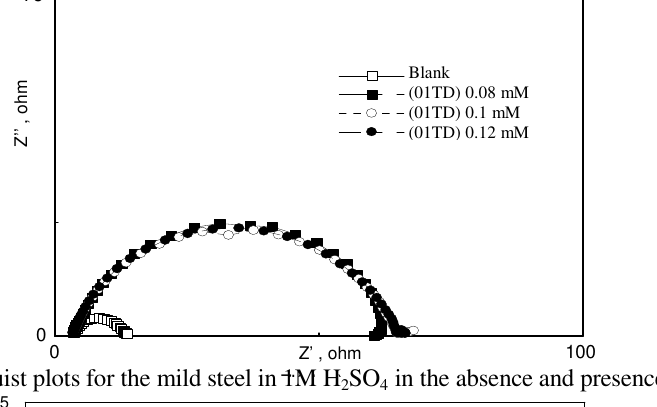
SO in the absence and presence of (01TD). 2 4